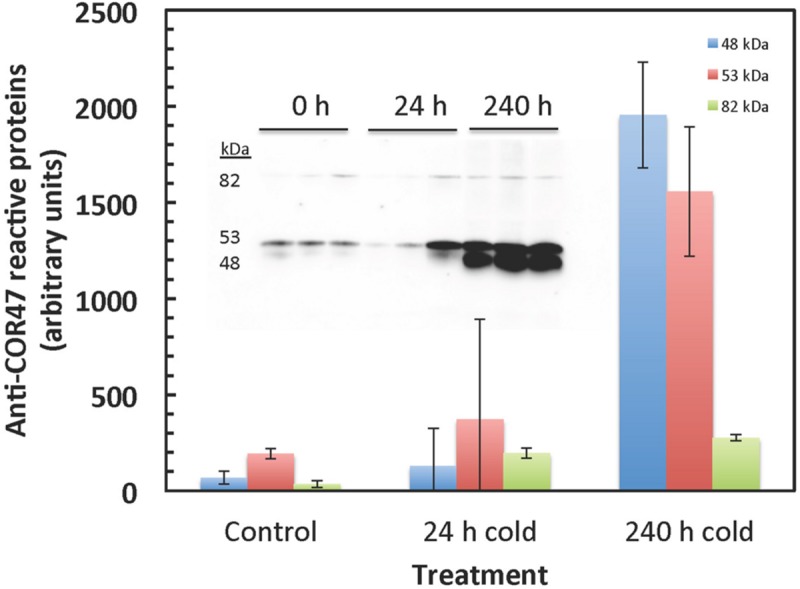
COR47-reactive bands strongly increase in response to cold. COR47 protein levels increase with extended cold treatment. Western blots were probed with antibody raised against Arabidopsis COR47. Two major bands were detected at 53 and 49 kDa, likely corresponding to the Fragaria COR47 homolog. The 53 kDa and the 49 kDa bands likely correspond to the phosphorylated and non-phosphorylated proteins, respectively. The upper minor protein (82 kDa) is probably an often observed aggregate of COR47. The insert shows the gel data used to calculate the averages and standard deviations.